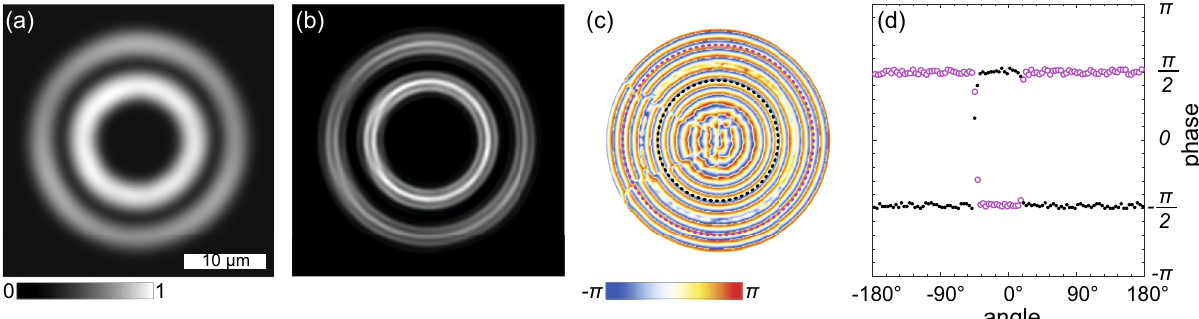
Figure 7. Simulation of the interferometry of the concentric ring polariton condensate with oscillating vorticity. Meaning of panels is the same as in Fig. 3. The density distribution ( a ) and the interferometry image ( b ) were obtained by superimposing density distributions and interferometry images of two polariton condensates with 1 . The relative phase distribution ( c ) was extracted from the interferometry image ( b ) using the 1 and m − = + Fourier-transform method adapted for closed-fringe